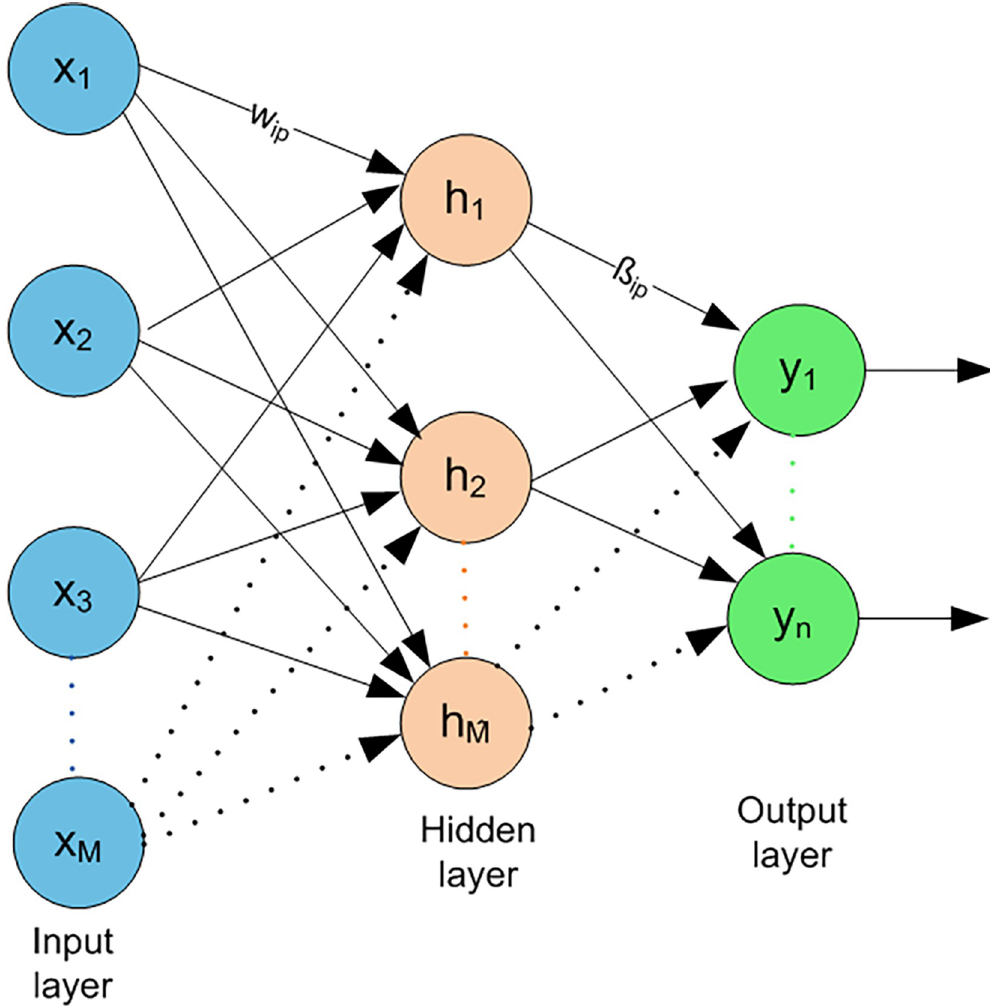
Fig 5. ELM schematic diagram